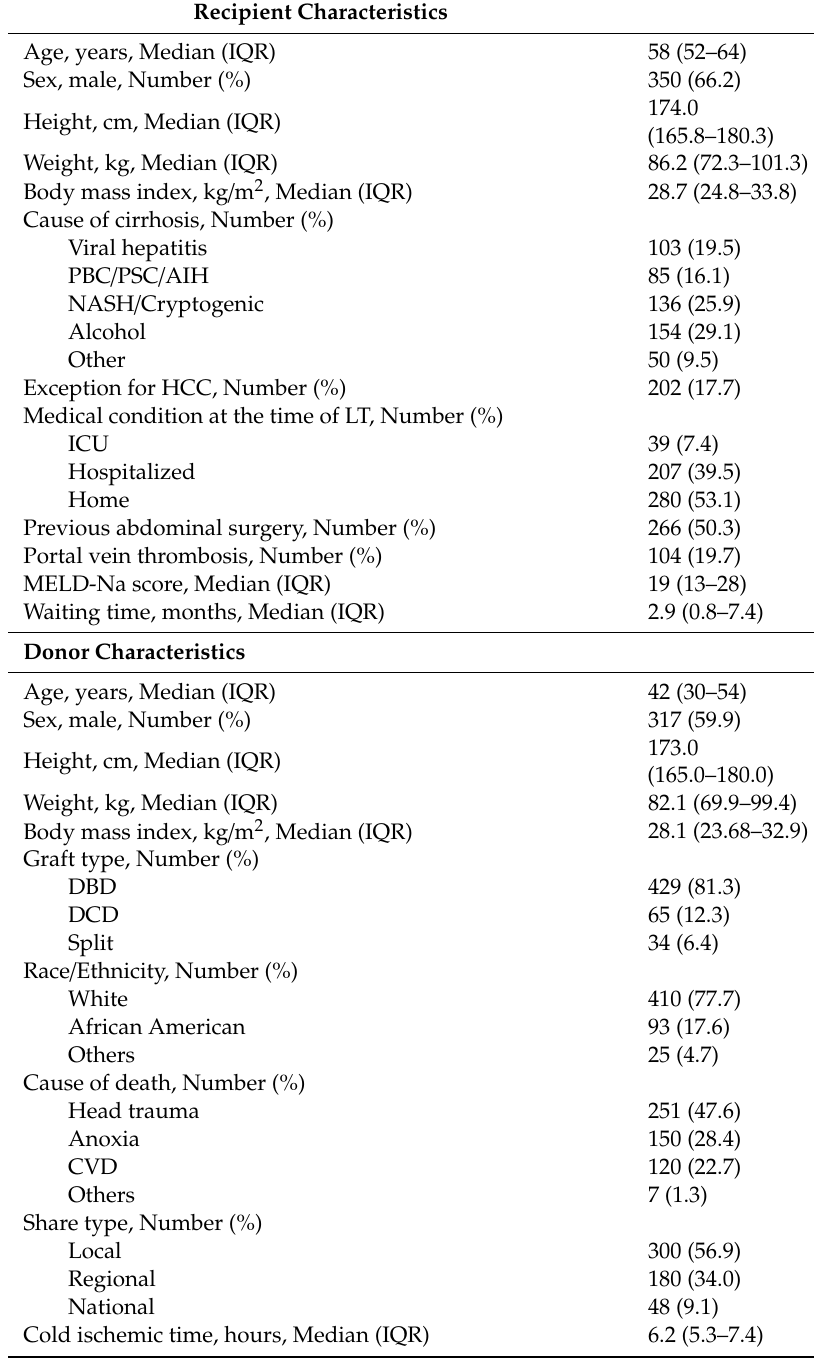
Table 1. Recipient and donor characteristics. LT: liver